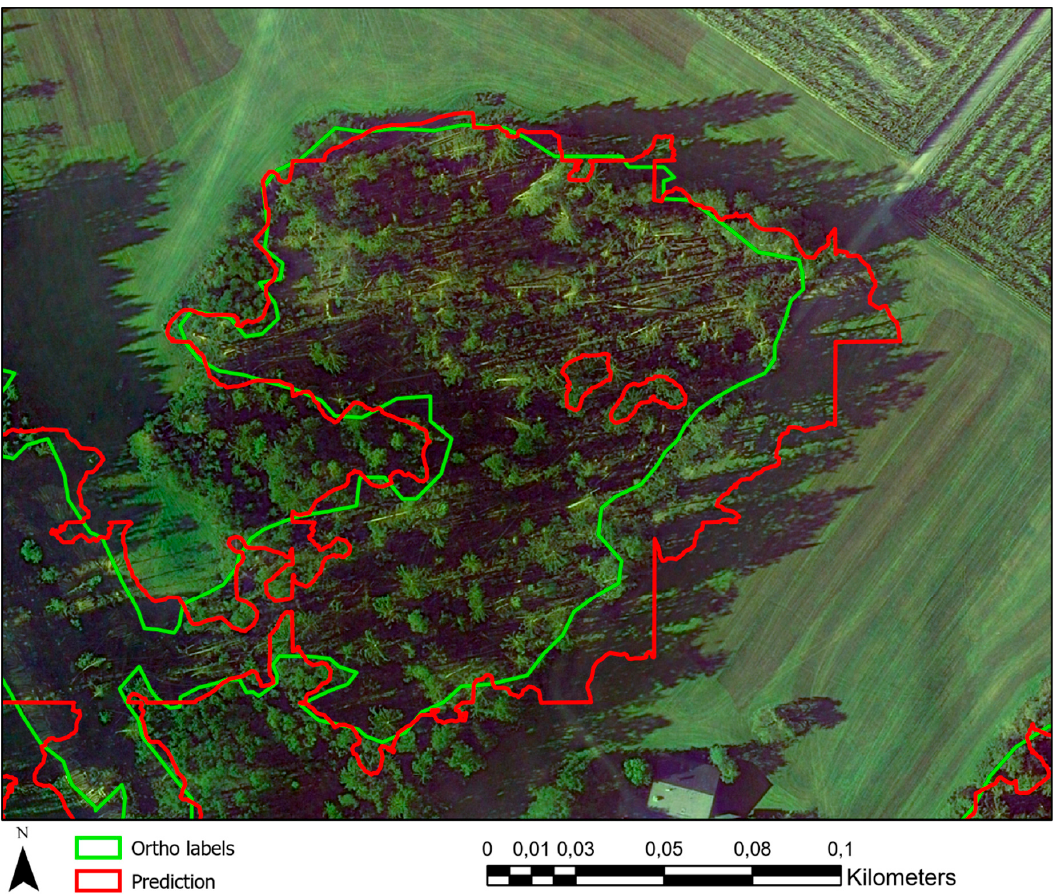
Figure 10. Prediction on orthophoto (red) overlain with the manually digitized reference polygons (green). Shadows lead to overestimating the damaged area by the model.